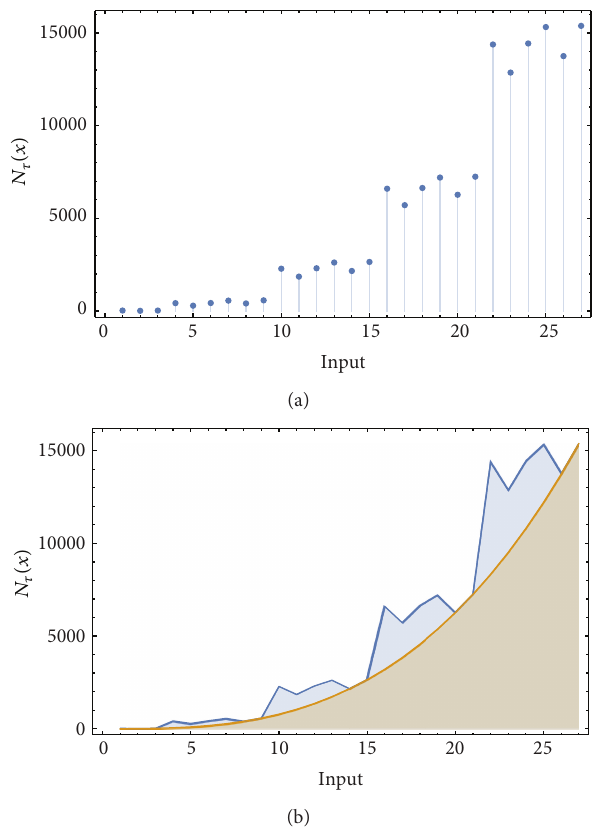
Figure 4: Alternating values for 𝑁 𝜏 (𝑥) with periodicity 6. The depicted values are for TM number 1159345. The diagram in (a) shows the data set and in (b) we included a fit from